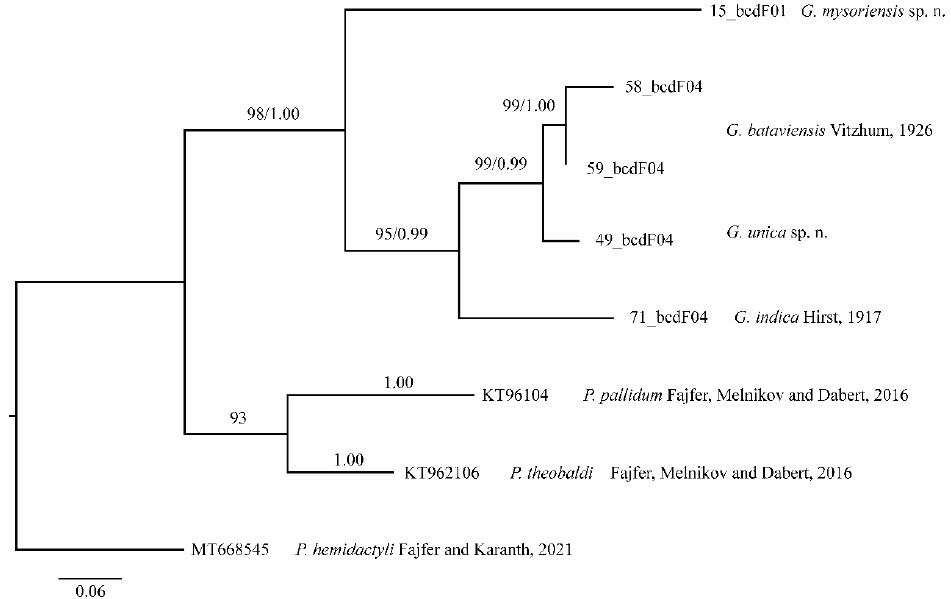
Figure 30. Maximum likelihood of COI mt DNA tree of the analysed Geckobia spp. Bayesian analysis yielded almost identical tree topology with only branches of the two Pterygosoma not resolved (polytomous). The support of branches is given as bootstrap value for 1000 replications followed by posterior probability index.